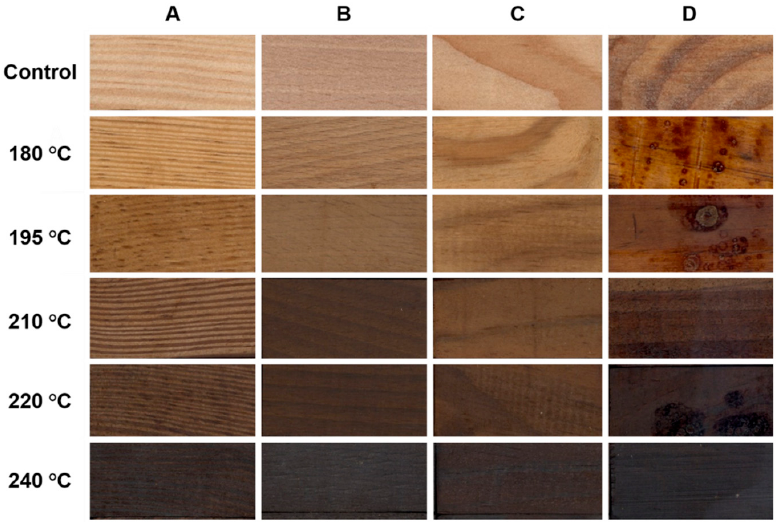
Figure 2. Thermally modified samples: Scots pine ( A ), beech ( B ), stone pine sapwood ( C ), stone pine heartwood ( D ).